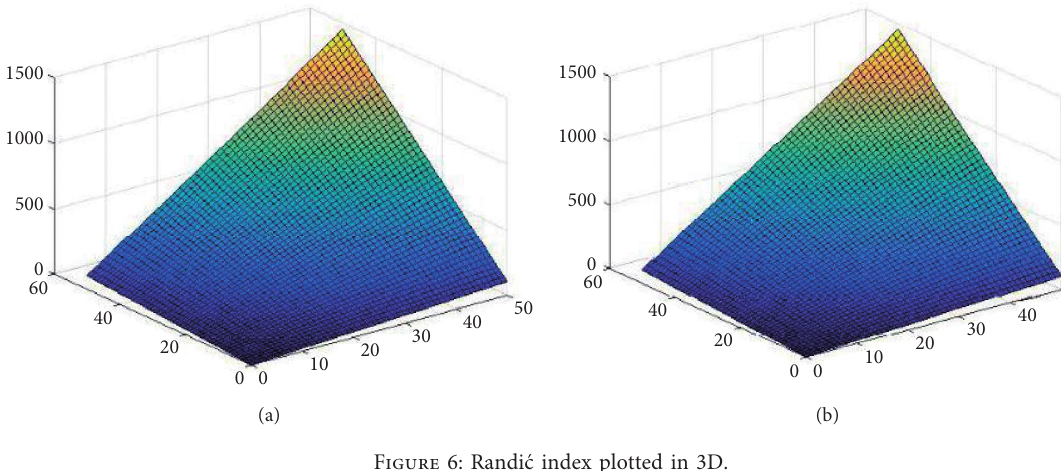
Figure 6: Randi´c index plotted in